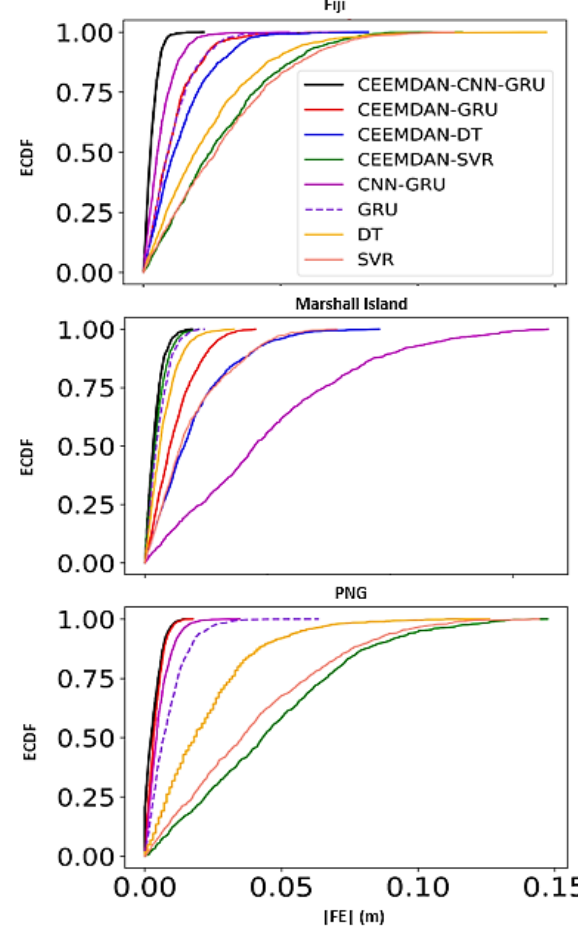
Figure 11. Empirical Cumulative Distribution function (ECDF) of forecasted error |FE| of MSL generated by the proposed CEEMDAN-CNN-GRU along with comparing models for three selected sites in the testing phase.